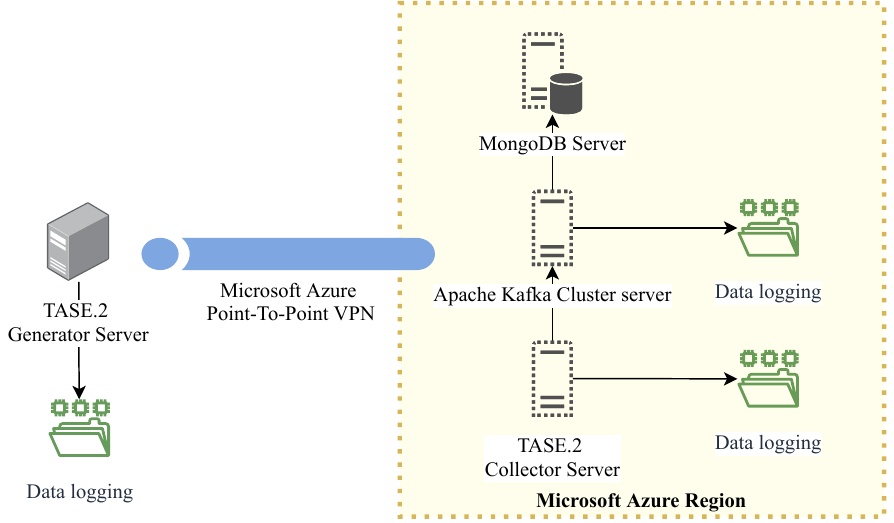
Figure 8. Topology of the components used during the experiments.